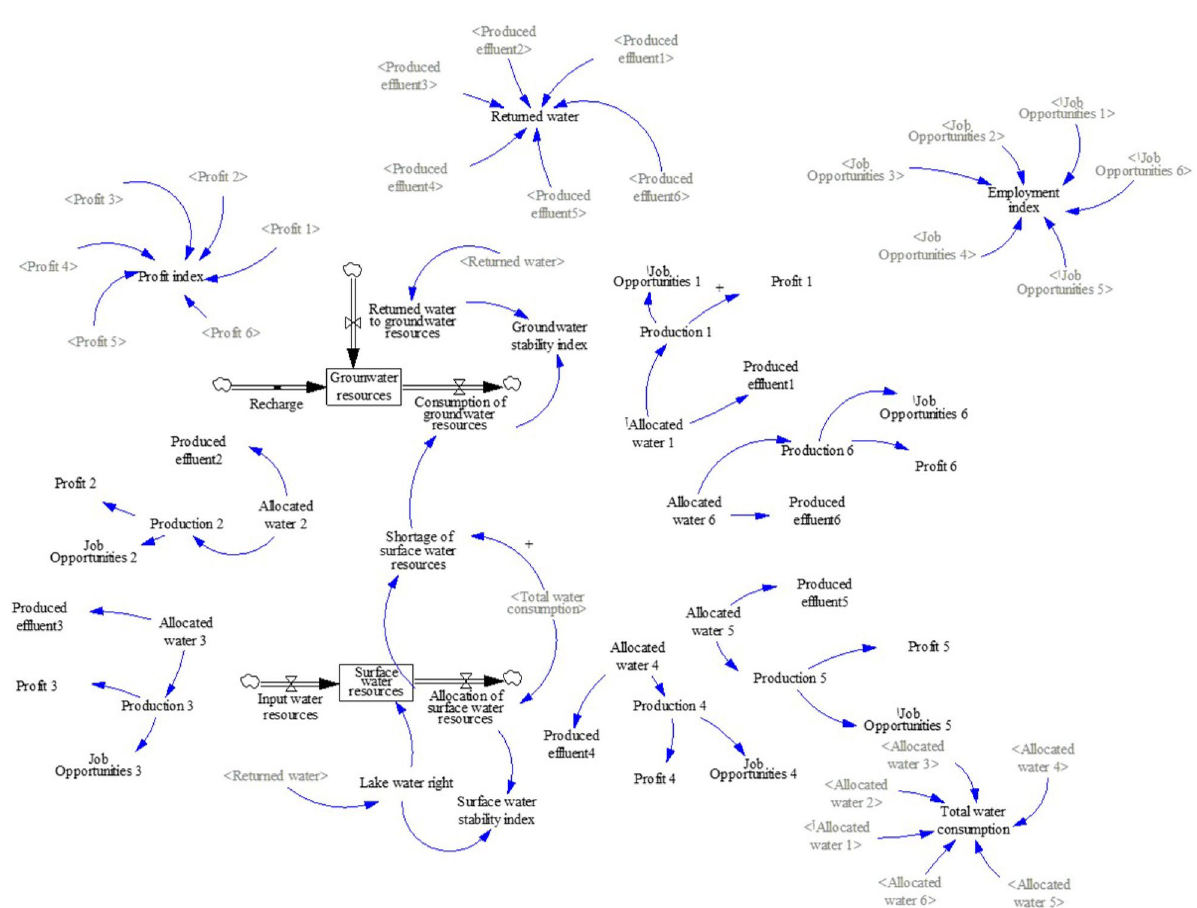
Figure 3. Stock and flow diagram of industrial water allocations of this